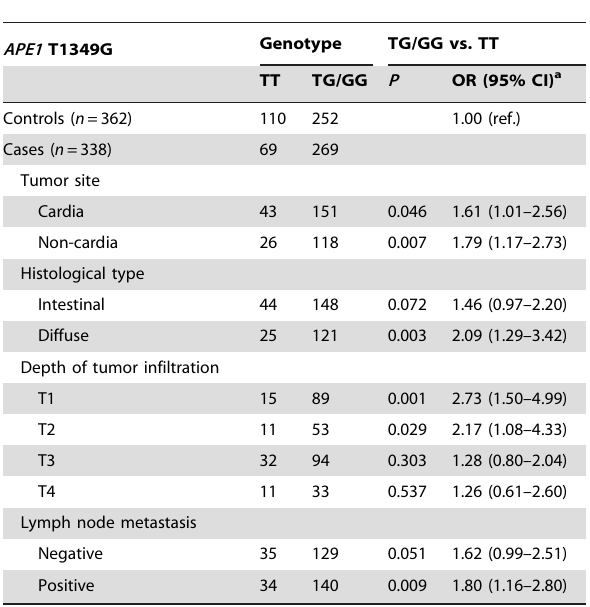
Table 4. Association between the APE1 T1349G polymorphism and clinicopathologic characteristics of gastric cancer risk.